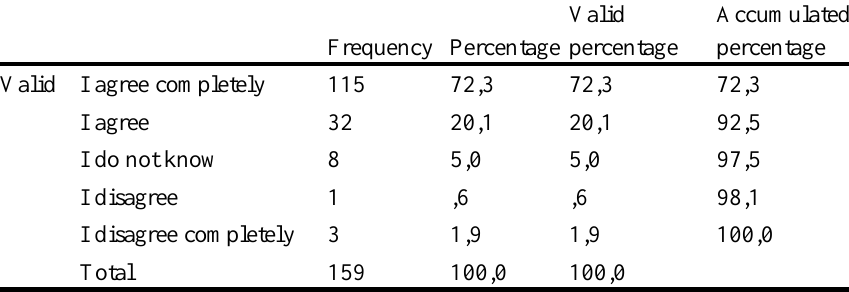
Valid percentage questionnaires´ results, question 2 “Students value the use of ICTs for learning